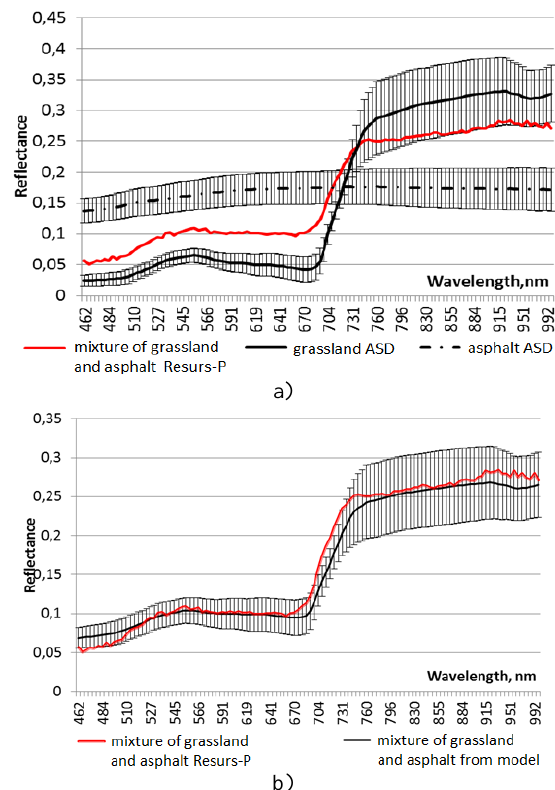
Figure. 7 Reflectance of asphalt and vegetation (a) and modelling reflectance of mixture of asphalt and vegetation